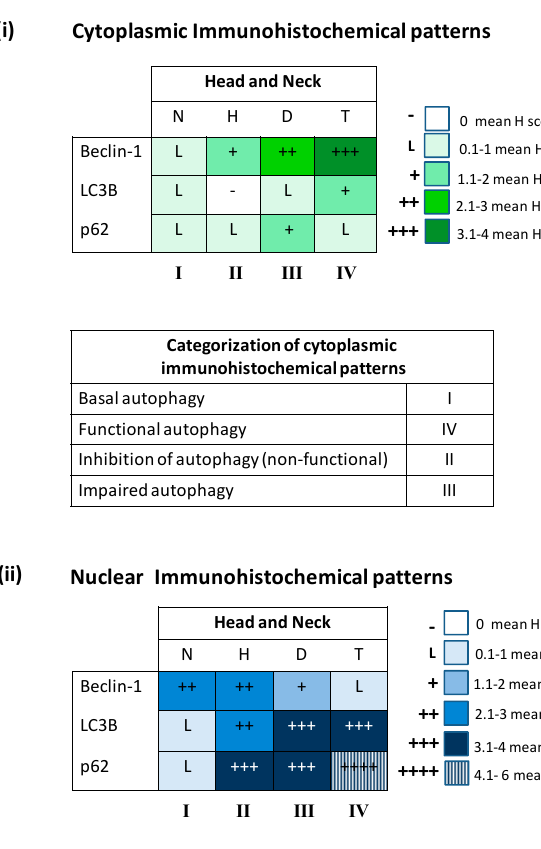
Figure 3. Color-coded charts showing ( i ) the cytoplasmic and ( ii ) the nuclear immunohistochemical patterns of the three studied autophagy-related markers (Beclin-1, LC3B and p62) in head and neck lesions. The color-coding is based on the classification of mHscore values as described in the Materials and Methods section. Four cytoplasmic and nuclear immunohistochemical patterns resulted, respectively, from the combination of the color-coded classes for each autophagy marker in every stage of cancer. Based on autophagic activity, the cytoplasmic patterns were grouped into four categories. The first category refers to basal autophagy represented by pattern I and characterized by low immunostaining of Beclin-1, LC3B and p62. The second category refers to competent autophagic activity represented by pattern IV, and was characterized by a lower p62 immunohistochemical staining compared to LC3B, indicative of proficient ability of intracellular components to be degraded via autophagy. The third category refers to inhibition of autophagy represented by pattern II, characterized by a faint staining of LC3B, since this is a key autophagy-related factor for autophagosome formation. The fourth category refers to impaired autophagic activity represented by pattern III. This was characterized by an increased p62 immunohistochemical staining compared to LC3B, indicative of a cytoplasmic p62 accumulation possibly resulting in the disturbance of cell function and